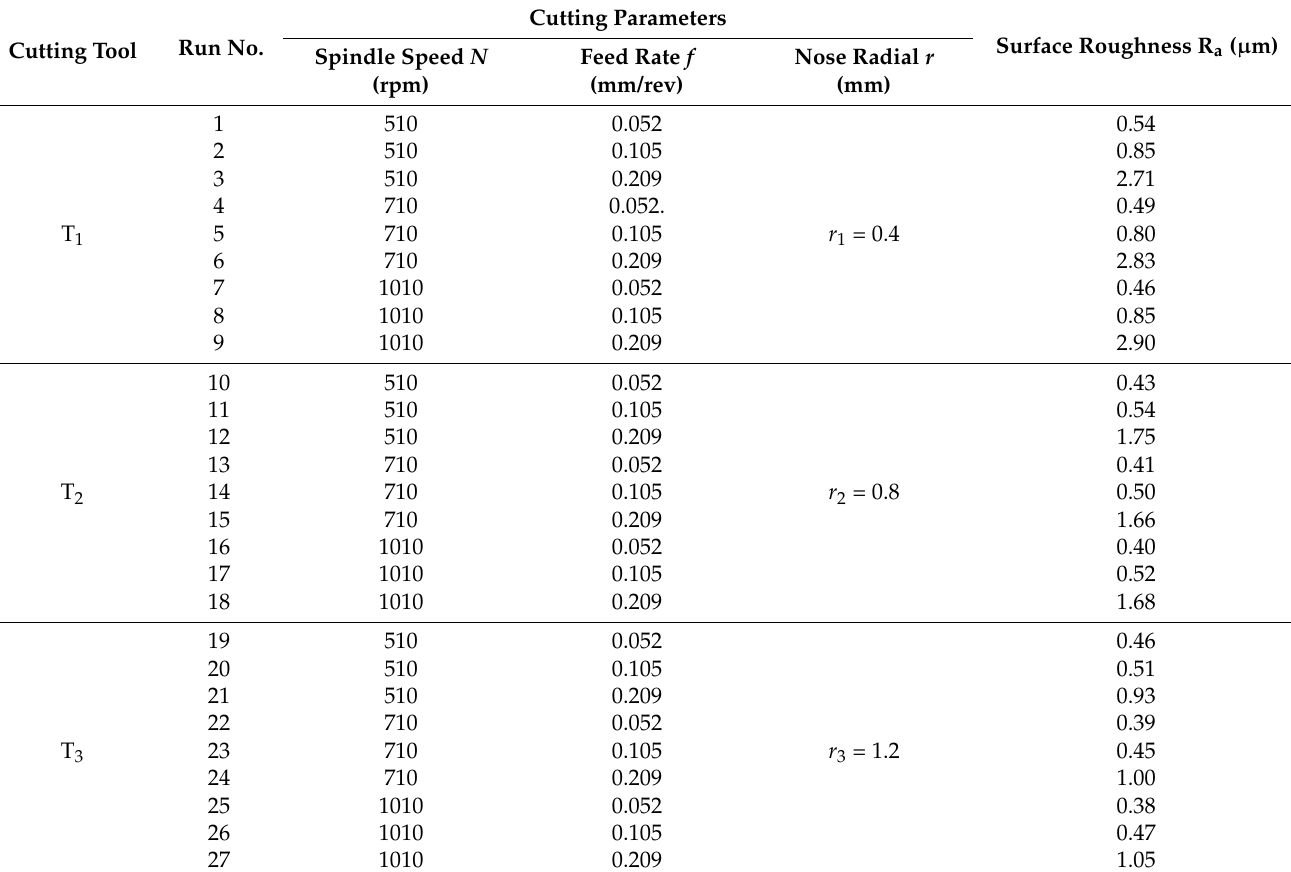
Table 2. Experimental results of surface roughness (R a ).